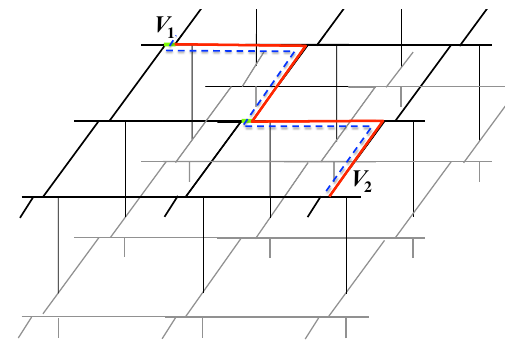
FIG. 7. The semion string operator on the surface. The curve C connecting the surface vertices V 1 and V 2 is shown in red. A second copy of C (shown in dashed blue), displaced from C along the ð − 1 ; − 1 ; 1 Þ direction, determines the set of R vertices. These are vertices where the dashed blue curve crosses over an edge e i (shown in green) of the surface. The edge i þ 1 is the edge in C that shares a vertex with e and is crossed second when following i C such that C turns to the right at these crossings.